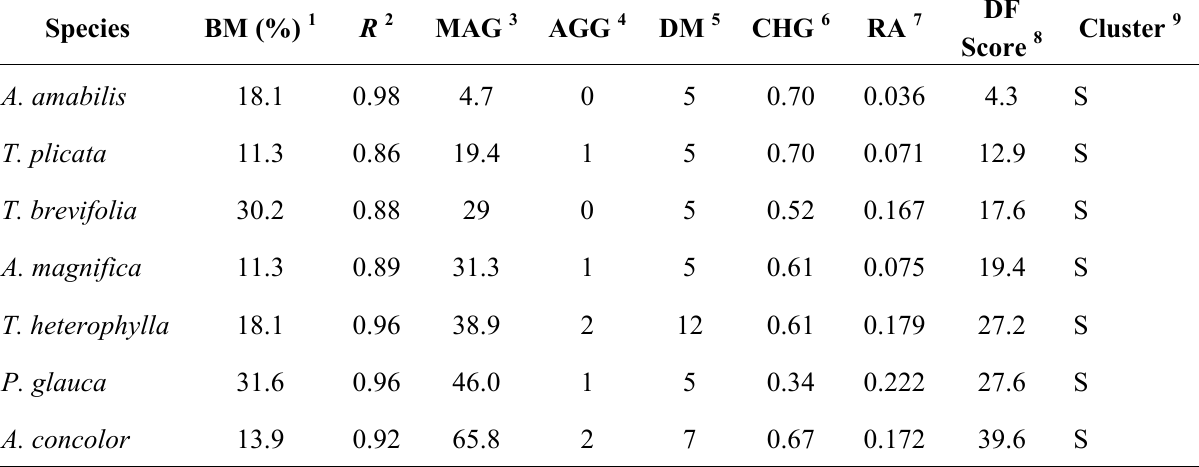
Table 2. Baseline percent mortality, correlation coefficient of regression of natural log of diameter distribution fit to the negative exponential model, diameter distribution metrics, discriminant function score, and cluster category for each of the 22 species populations